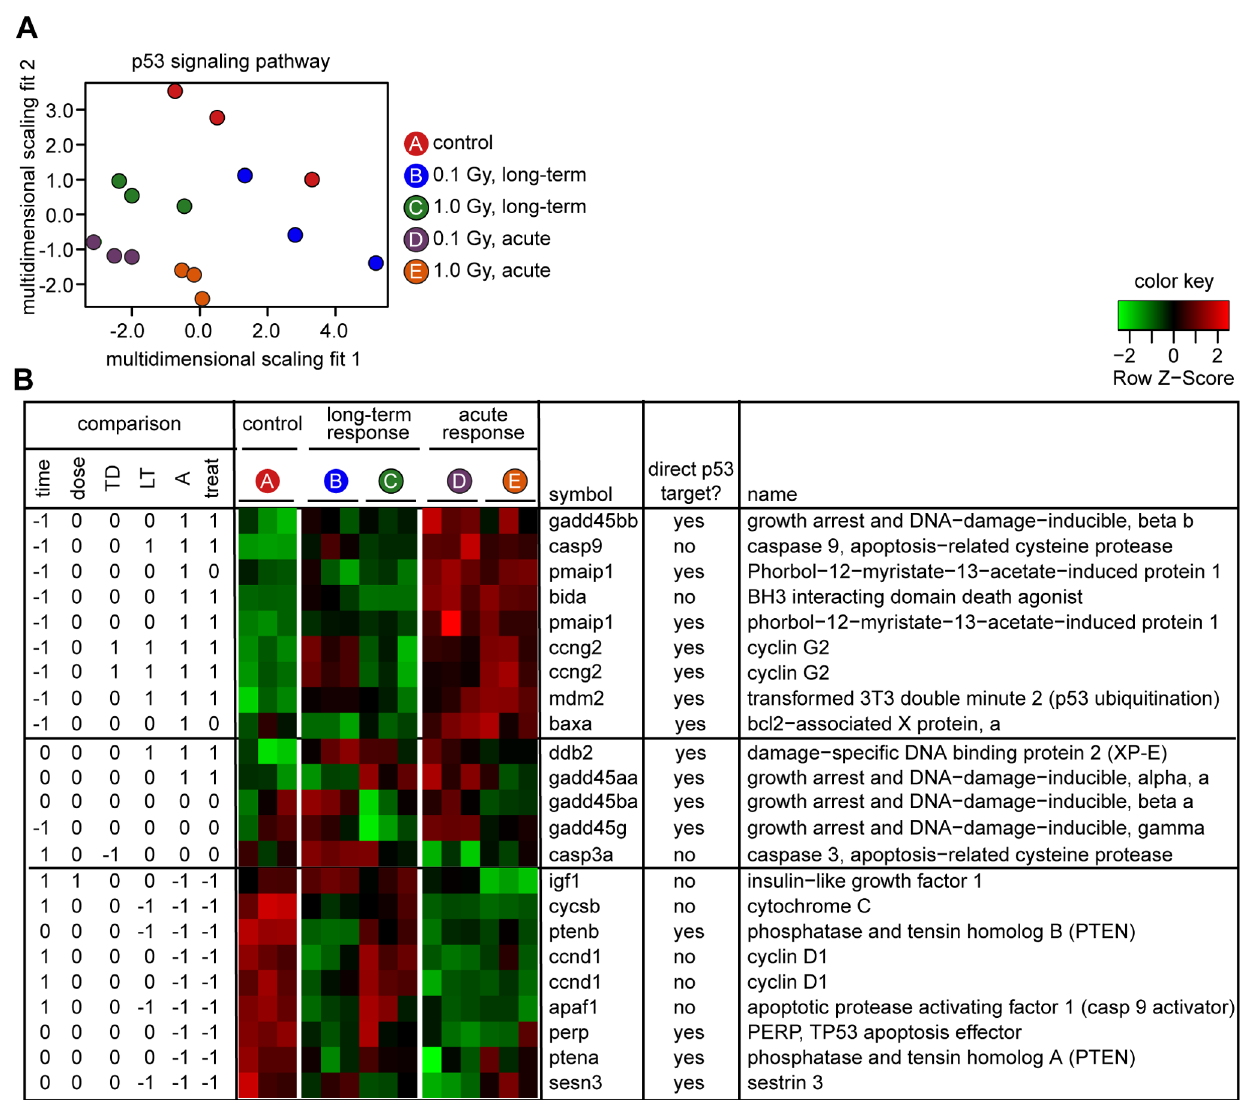
Figure 4. Analysis of p53 signaling pathway. A. Multidimensional scaling representation of results for the p53-signaling pathway, based on 36 probe sets for which data are available. Each symbol represents one biological replicate. Color denotes treatment group as indicated. B. Response for 23 probe sets that showed statistically significant differences in one or more comparisons. (Results of comparisons are expressed as ‘‘1’’, ‘‘0’’ or ‘‘ 2 1’’ using the same convention as in Figure 2). One gene (gadd45ba) was included because it was significant in an overall F test, although not in any of the individual comparisons. Left, results of statistical comparisons, notation as in Figures 1 and 2. Center, heat map, as in Figure 2. When more than one row has the same gene symbol, it indicates different probe sets directed against the same mRNA. Right, gene symbols, whether gene is a direct target of the p53 transcription factor, and gene name. In some cases, an alternative name or description of gene function is given in parentheses. For details of KEGG p53 signaling pathway – Danio rerio (zebrafish):